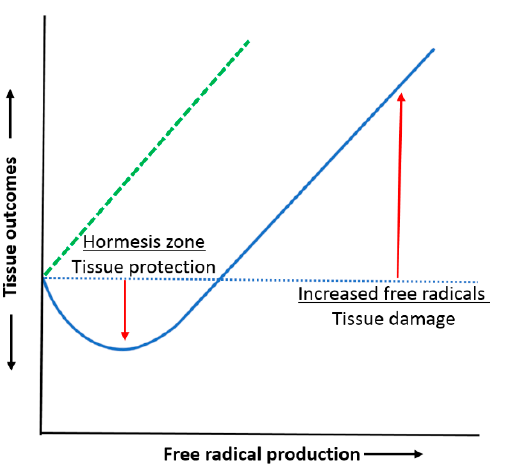
Figure 2. Hormesis curve showing enhanced tissue protection by antioxidants through their priming by low level free radical production: protection from free radical surge; hormesis zone (blue curve). Lack of added protection (hormesis) with free radical surge when free radical exposure is already pre-reduced using antioxidants, with subsequent greater damage at higher free radical levels: damage curve shifted to the left (dashed green line).